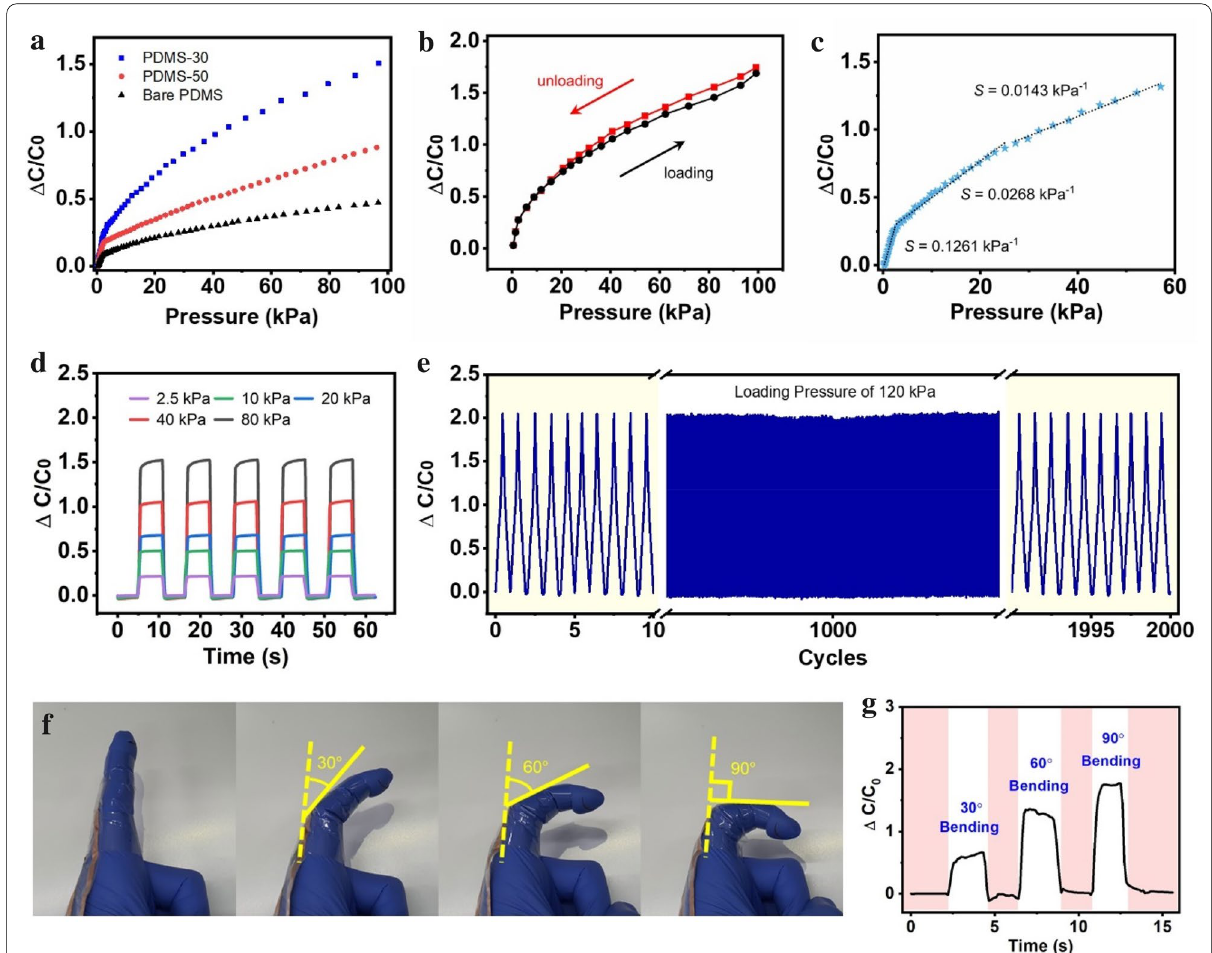
Fig. 4 a Pressure-response (relative capacitance) curves as function of the applied pressure for three weight concentrations of PDMS: 30 wt% (blue squares), 50 wt% (red circles), and the bare PDMS sample (black triangles). b Hysteresis characteristics of the PDMS-30-based pressure sensor. c Sensitivity measurements S in three different pressure ranges (PDMS-30). d Capacitance responses of the PDMS-30-based pressure sensor under various applied pressures. e Working stability and durability outcomes of the PDMS-30-based pressure sensor after 2000 cycles under applied pressure of 120 kPa. f Images of the index finger for three different bending angles. g Capacitance responses of the bending of the index